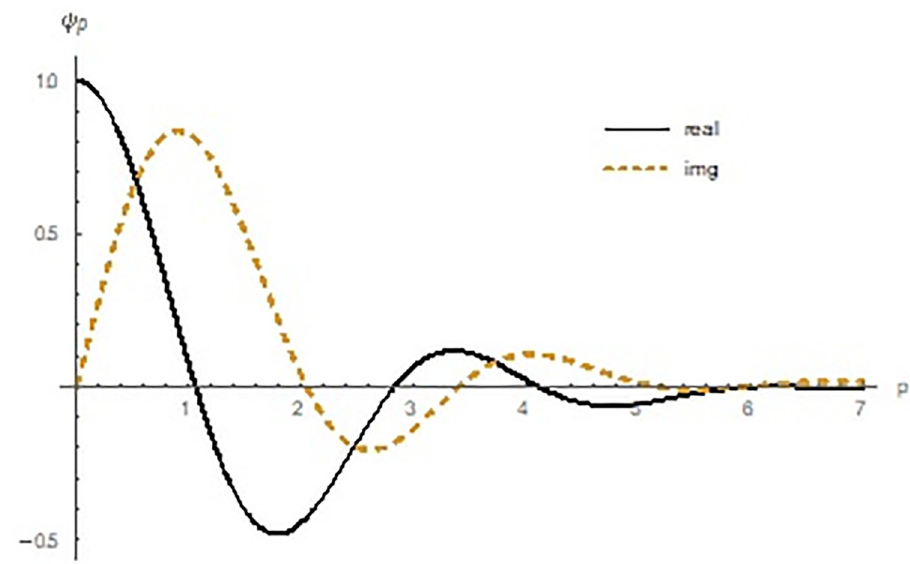
Fig 4. Graphical display of real and imaginary parts of characteristics function of hcMB − III